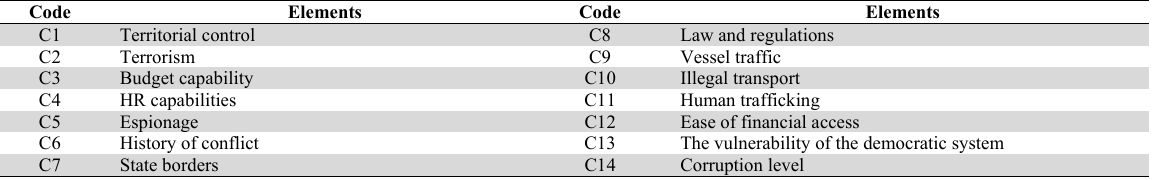
Elements of Social Vulnerability in the Development of the Islamic State (IS)